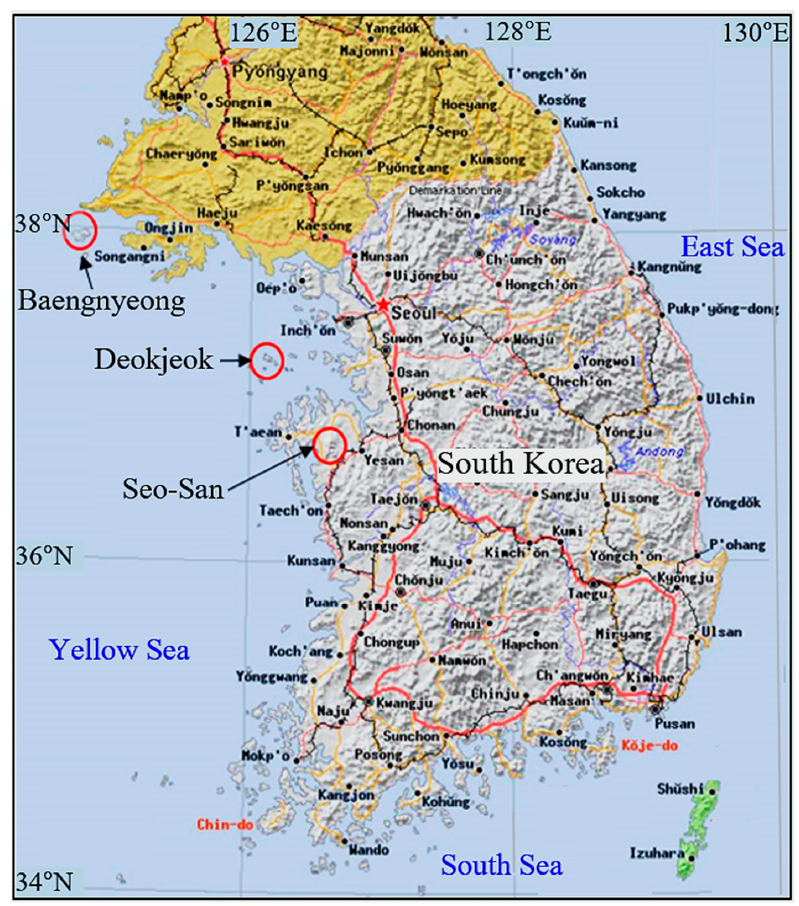
Figure 1. Locations of feasibility analysis (Source: Google Maps).